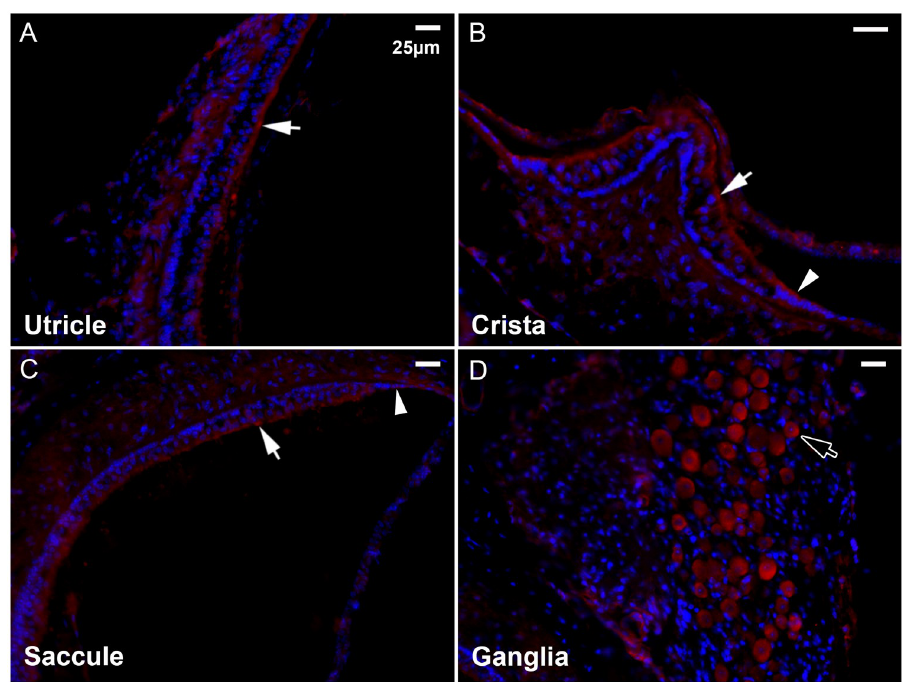
Fig 4. Fluorescent immunostaining of Pcdhga10 in the murine vestibule at 2 months of age. Arrows indicate hair cells, arrowheads transitional epithelial cells and hollow arrow vestibular ganglia. Scale bar, 25 μ m.